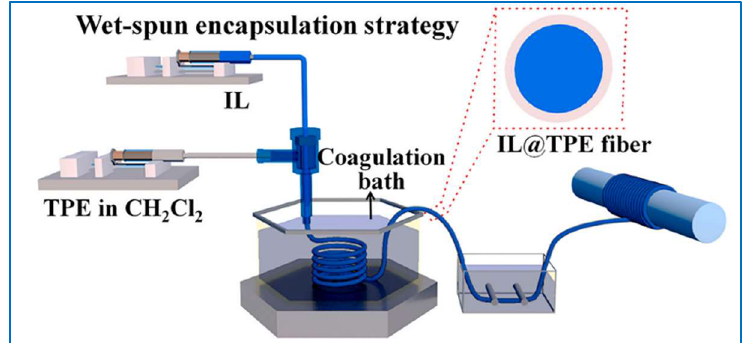
Figure 7. Schematic of preparation process of the IL@TPE fibers via wet spinning